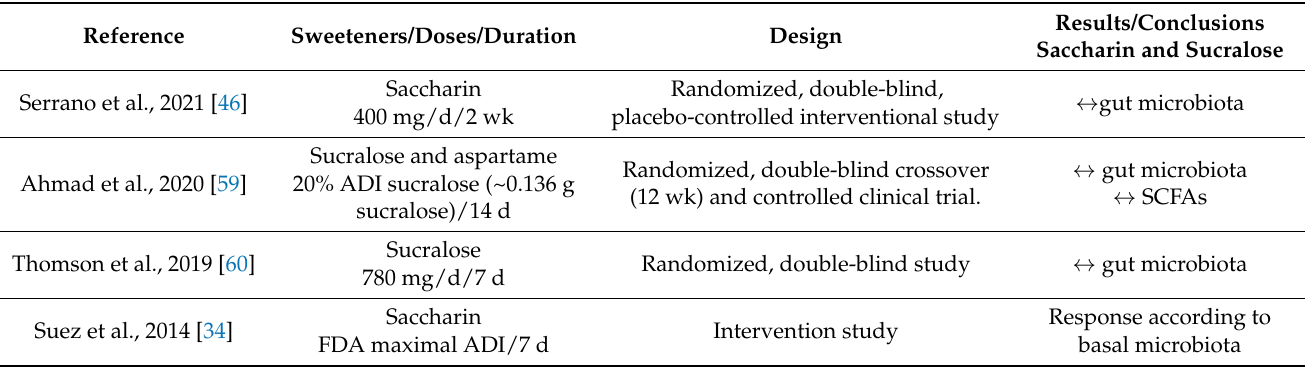
Table 5. Summary of the analyzed in vivo studies.